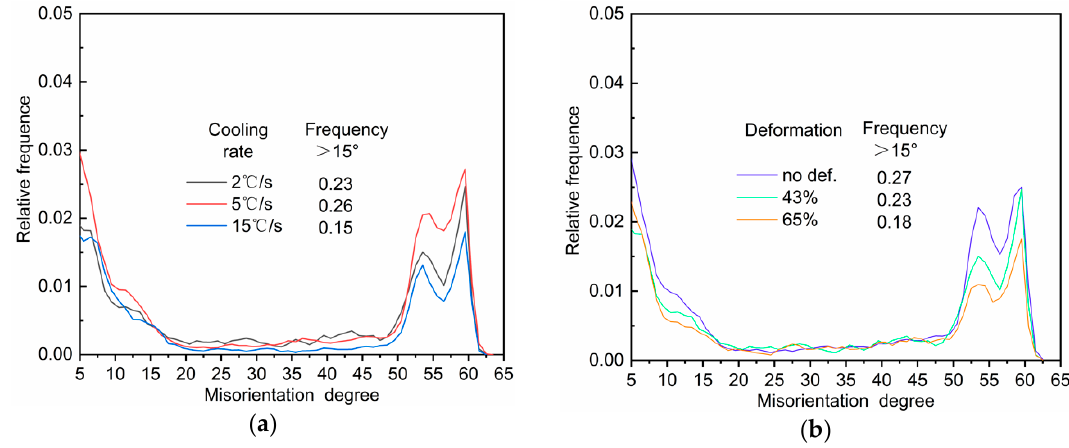
Figure 15. Grain boundary misorientation angle distribution in TC# steel samples under different thermomechanical treatment conditions.